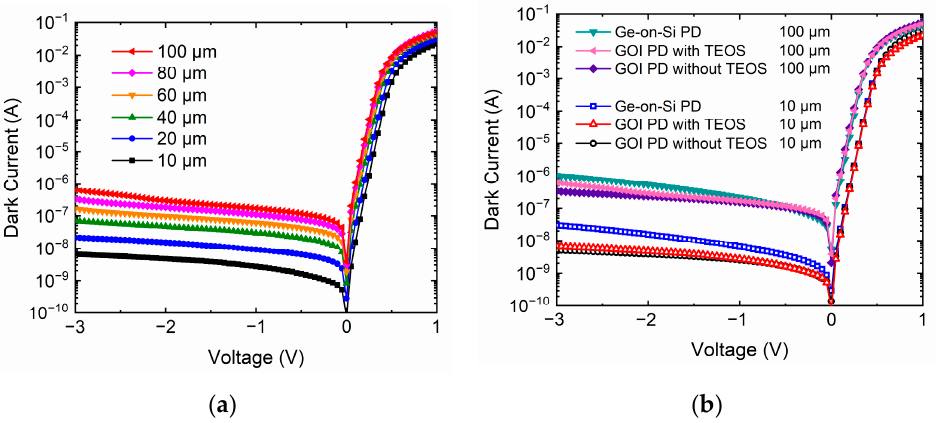
Figure 3. Dark currents of ( a ) GOI detectors with diameters of 10, 20, 40, 60, 80, and 100 µ m, and ( b ) detectors on three types of substrates with diameters of 10 and 80 µ